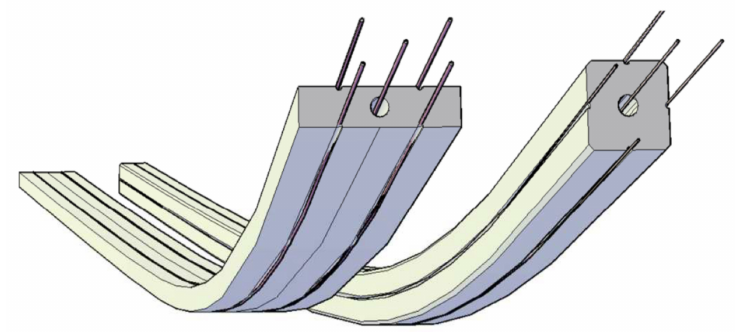
Figure 5. Initial concepts of 3DSensor consisted of a composite core and a set of precisely arranged optical fibres for strain